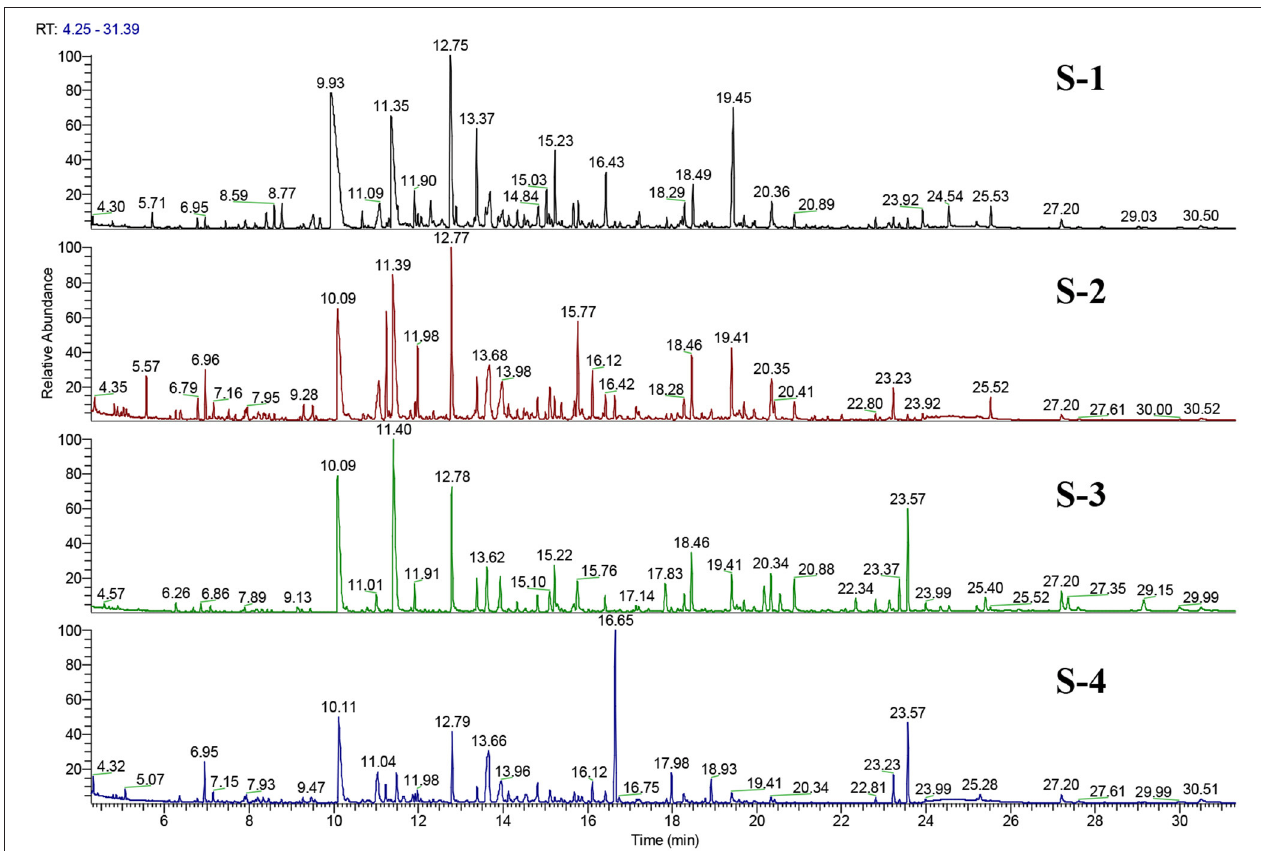
FIGURE 6 | Total ion chromatogram (TIC) of GC-O/MS (EI-mode) representing separation of the volatile fraction of the four feed extracts. Both S-1 and S-2 exhibit the same major peaks, but in some cases with different